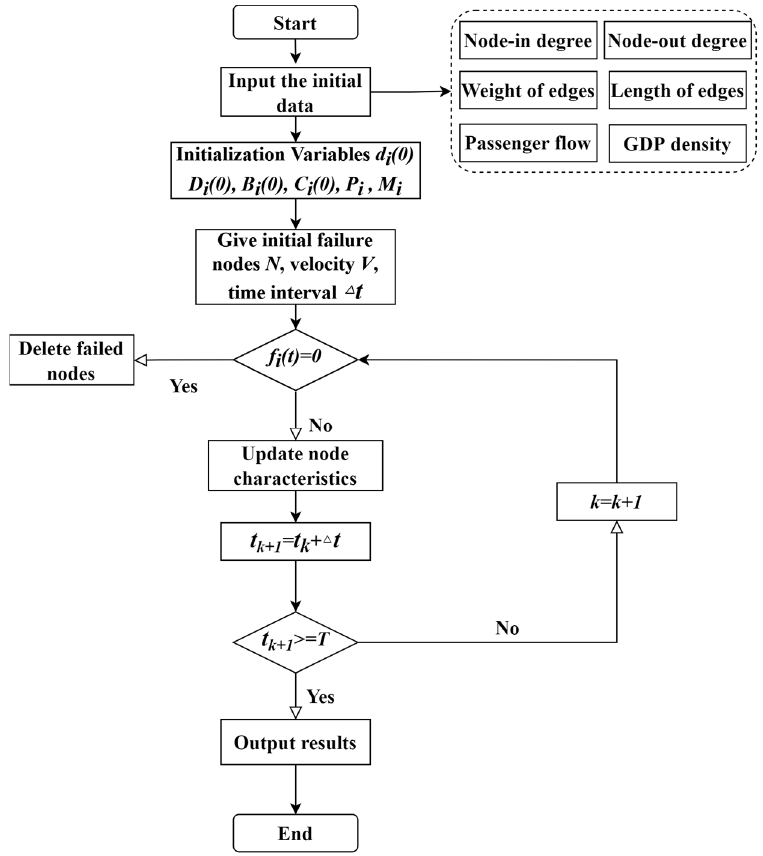
Figure 9. Flow chart of dynamic node breakdown algorithm.